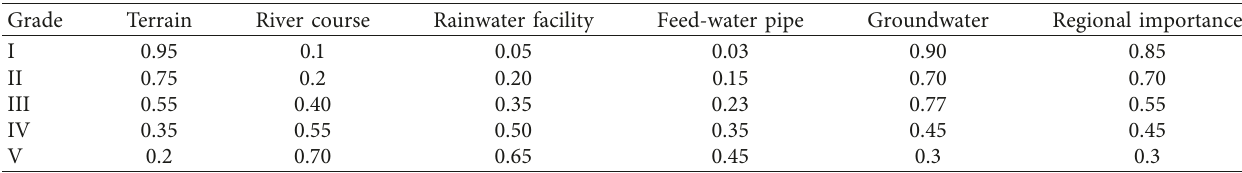
Table 5: Grading criteria for evaluation indexes.